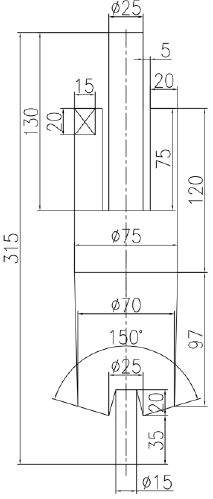
Figure 2. Structure of W-shaped hydrocyclone.